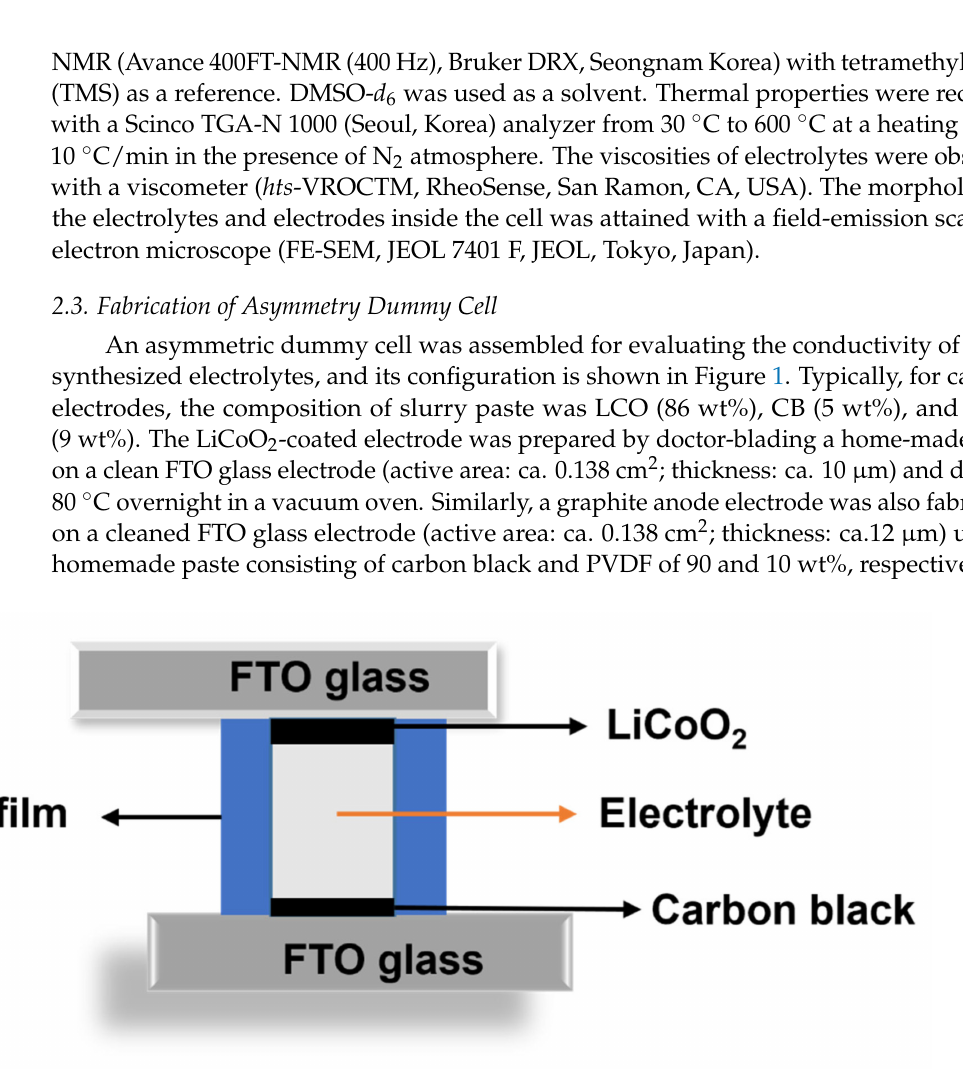
Figure 1. Schematic diagram of an asymmetric dummy